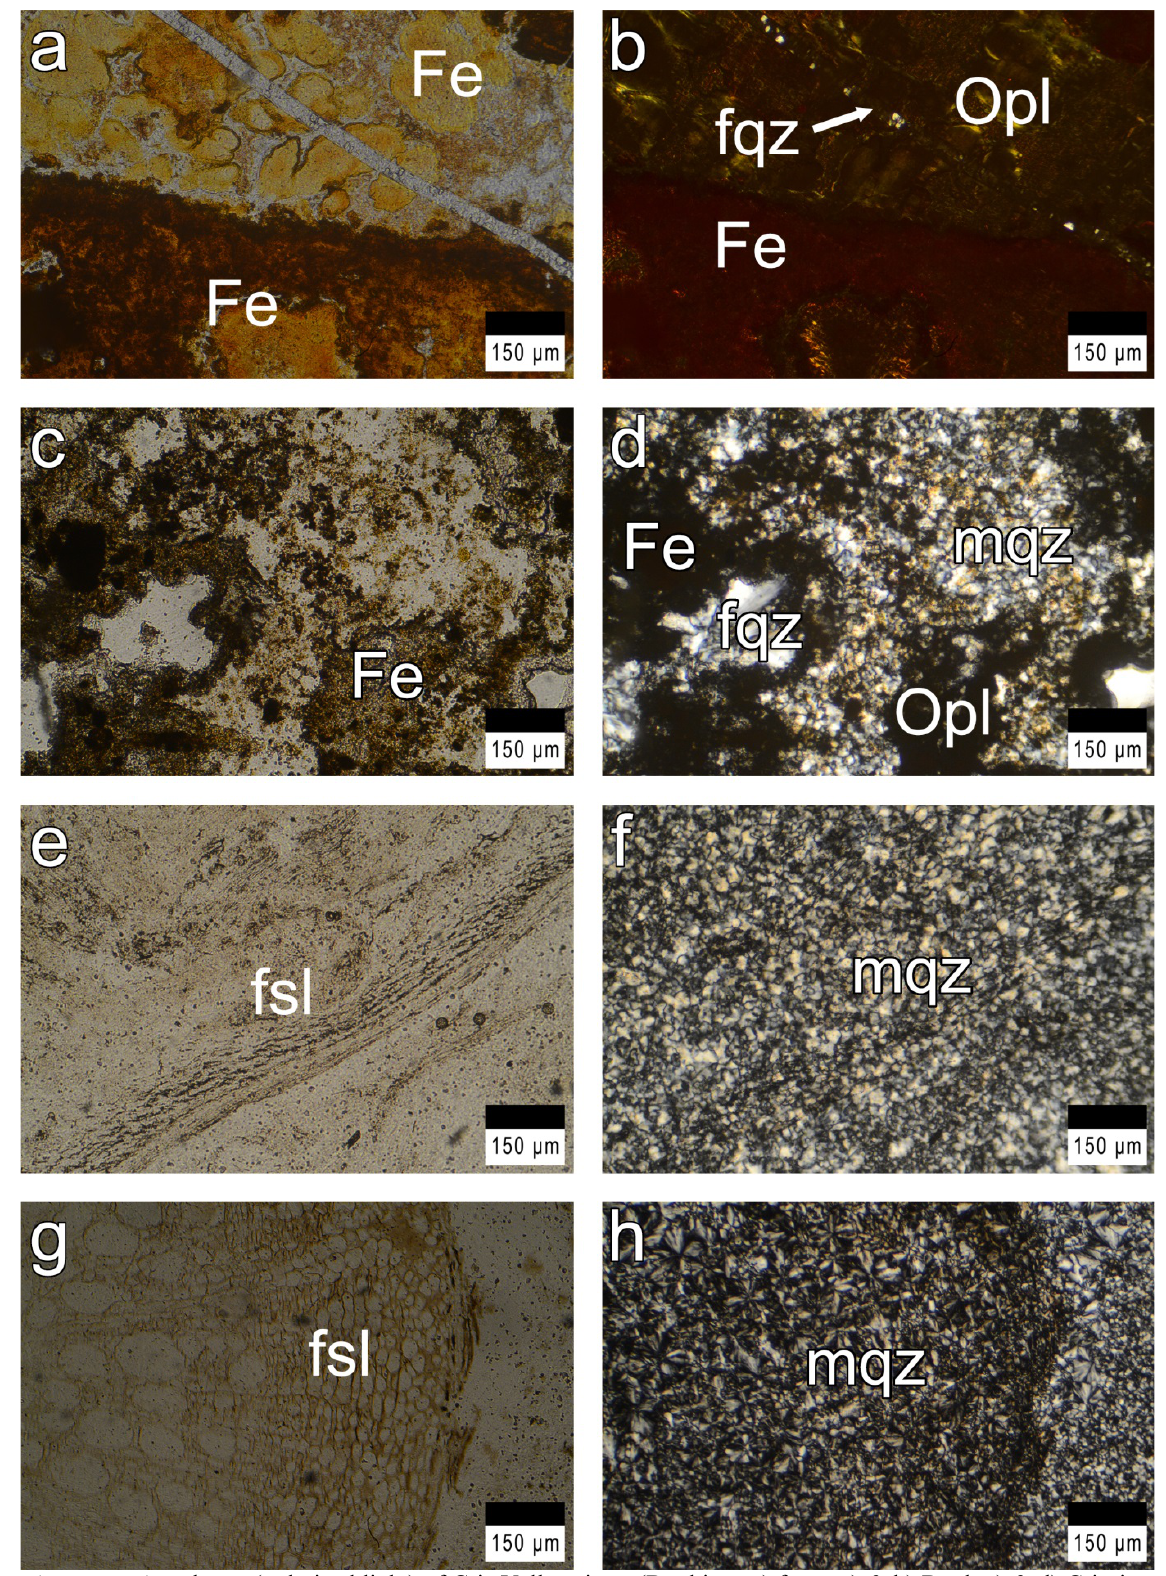
Figure 4. Microphotos (polarized light) of Criș Valley sinter (Brad jasper) from: a) & b) Brad; c) & d) Crișcior; e) & f) Brotuna; g) & h) Ociu. Left side, one polarizer (1P). Right side, the same with crossed polarizers (+P). Abbreviations: Fe for Fe-rich phase, Opl for opal, mqz for microgranular quartz, fqz for fibrous quartz, fsl for fossil (plant fossils in these cases). In e and f, relic vegetal tissue replaced by later microquartz (f and h) are